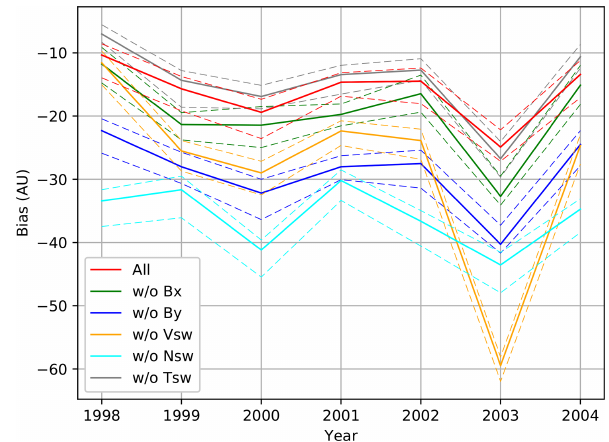
Figure 7. Mean deviation in each year for the various synthetic AU indices with the effect of one of the solar-wind parameters